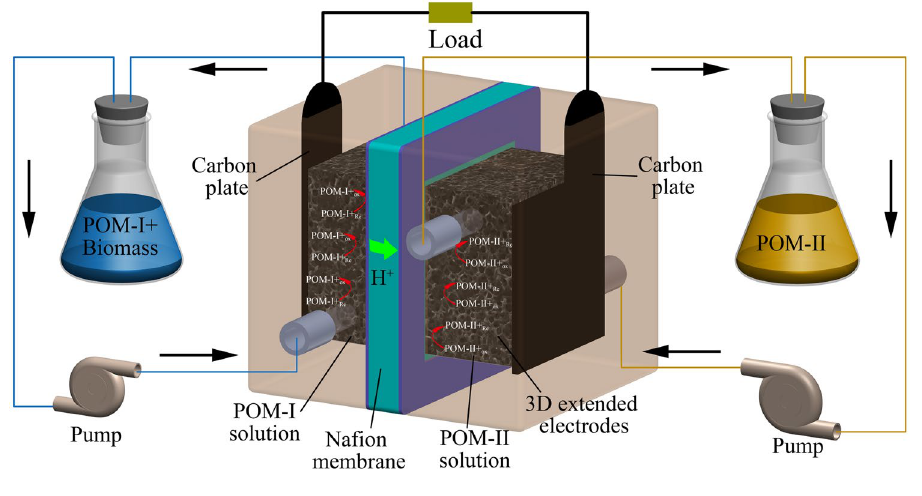
Figure 1. Structure of the